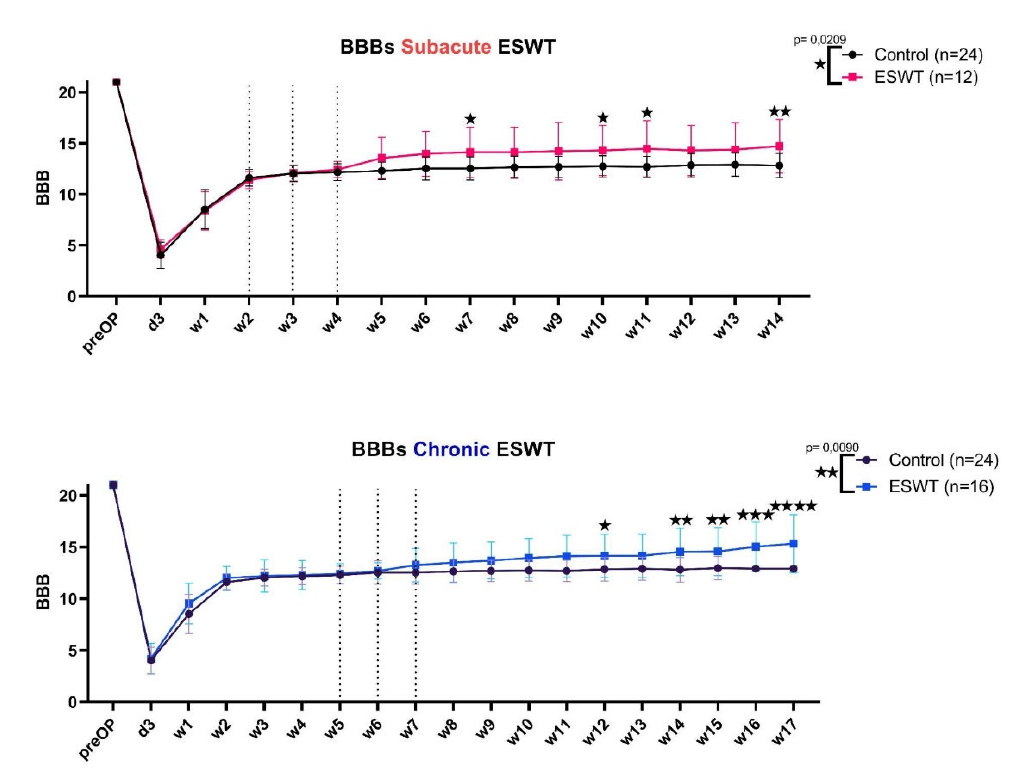
Figure 2. BBB-Scores (Basso, Beattie and Bresnahan locomotor score) of subacute ( a ) and chronic ( b ) ESWT (extracorporeal shockwave therapy) settings. In ( a ), the mean BBB-Scores of the subacute ESWT group (red) are compared to the control group (black). In ( b ), the mean BBB-Scores of the chronic ESWT group (blue) are compared to the control group. On the x-axis, time is plotted against the y-axis with the respective BBB-Score. Error bars indicate standard deviation. RM 2-way ANOVA was performed, and significant differences between groups are indicated by an asterisk (values with p<0.05 are summarized as a single asterisk “ ★ ”, p < 0.01 as ” ★★ ”, p < 0.001 as ” ★★★ ”, p < 0.0001 as ” ★★★★ ”). The p ‐ value for the treatment effect is shown in the top right for each experimental set ‐ ting.